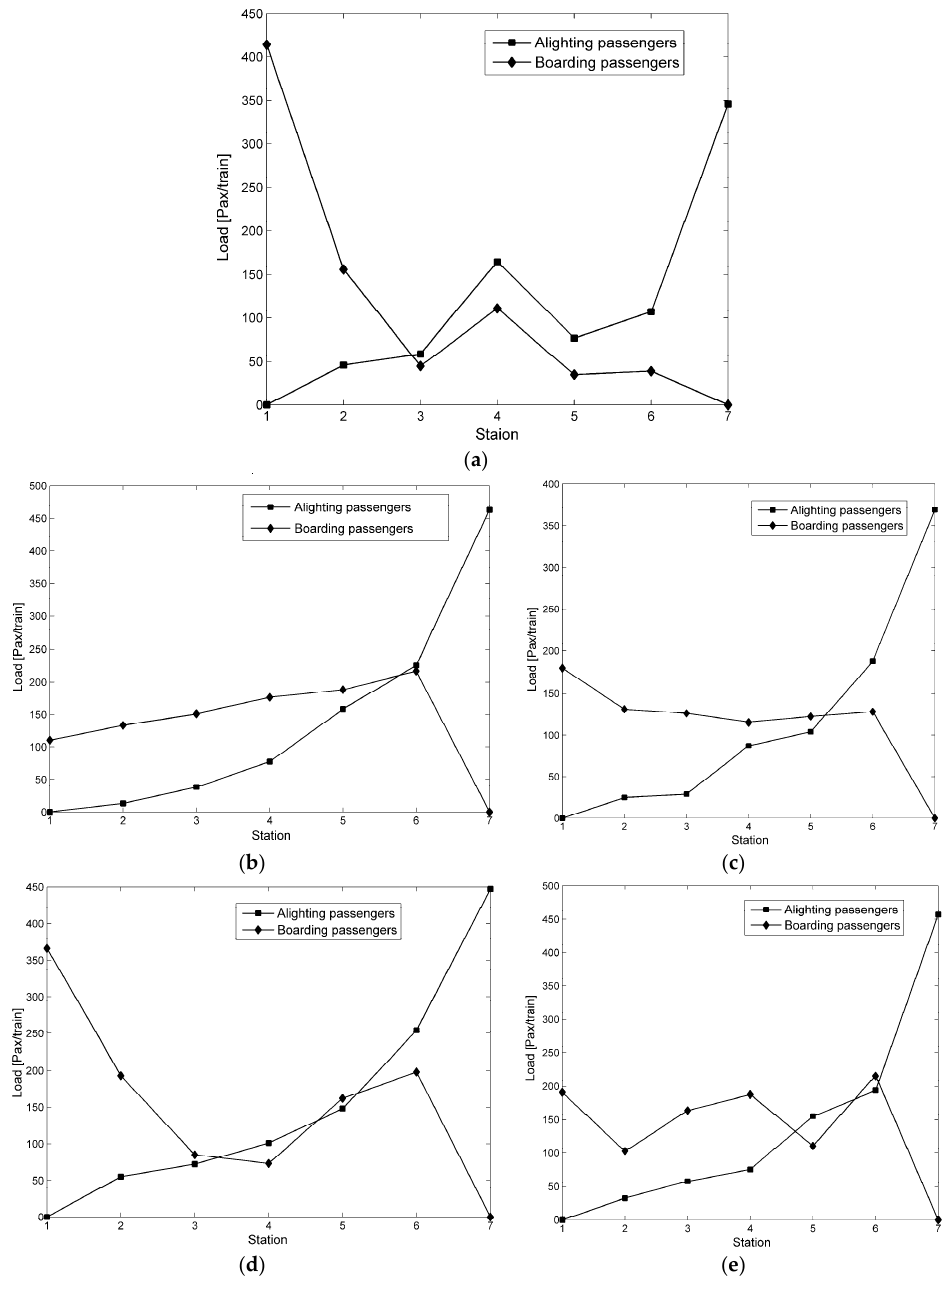
Figure 5. Load profiles of time-dependent demands. ( a ) Example 1. ( b ) Example 2. ( c ) Example 3. ( d ) Example 4. ( e ) Example 5.